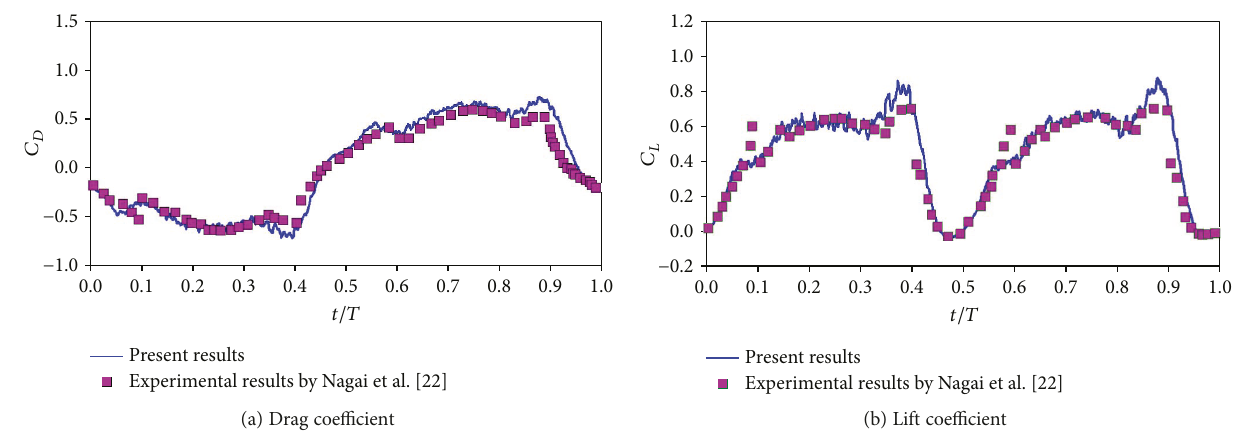
Figure 6: Comparison of the drag and lift coe ffi cient of the wing obtained by the present numerical method and literature experimental